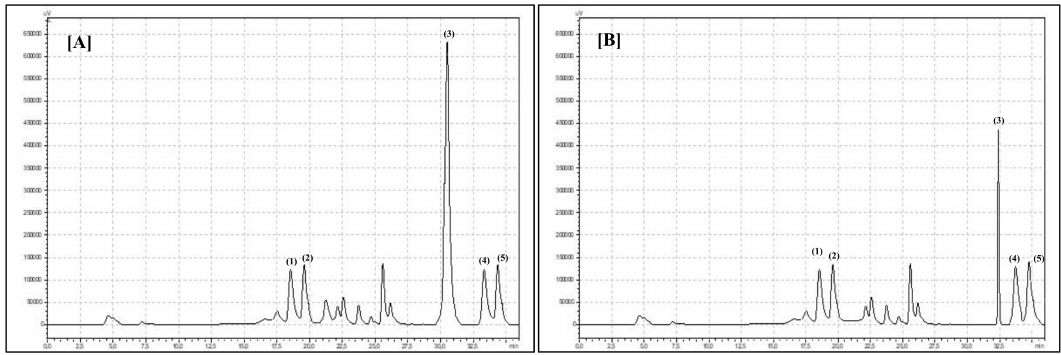
Figure 2. Chromatogram showing retention times for flavonols identified in flowers of ( A ) Robinia pseudoacacia L. and ( B ) Robinia hispida : (1) myricetin, (2) apigenin, (3) luteolin, (4) quercetin-3 - O -glucoside, and (5) kaempferol.